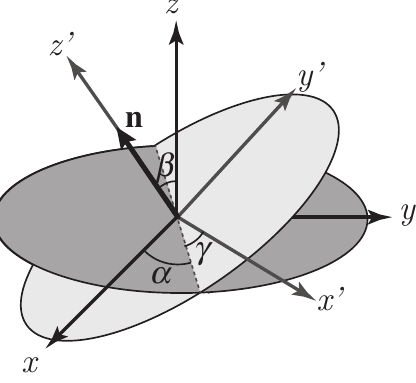
Figure 2. Diagram scheme with the Euler angles. The LC director vector is identified with n